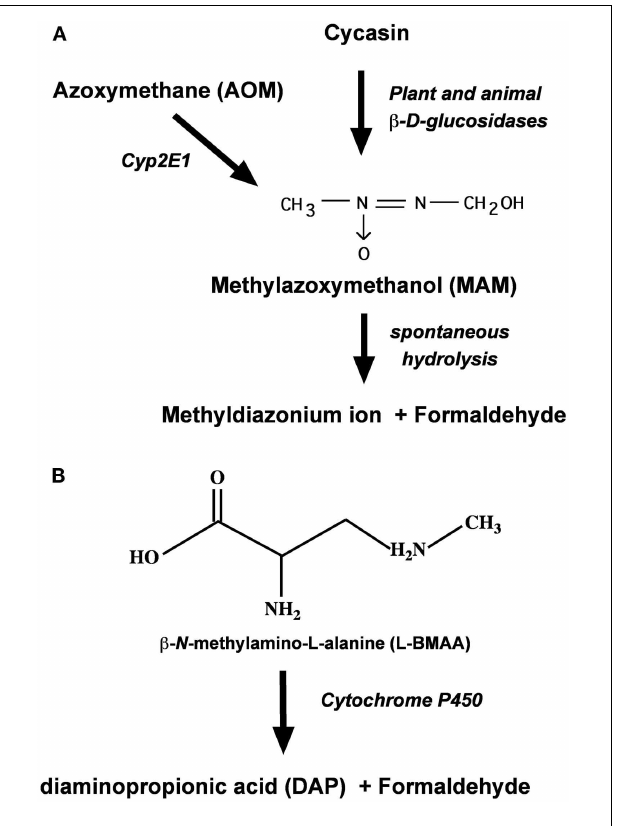
FIGURE 2 | Metabolism of the cycad toxins cycasin, MAM, and L-BMAA by plant and animal tissues. (A) Enzymatic conversion of cycasin or azoxymethane to MAM and its degradation product formaldehyde. (B) Enzymatic N -demethylation of L-BMAA by brain P450 to